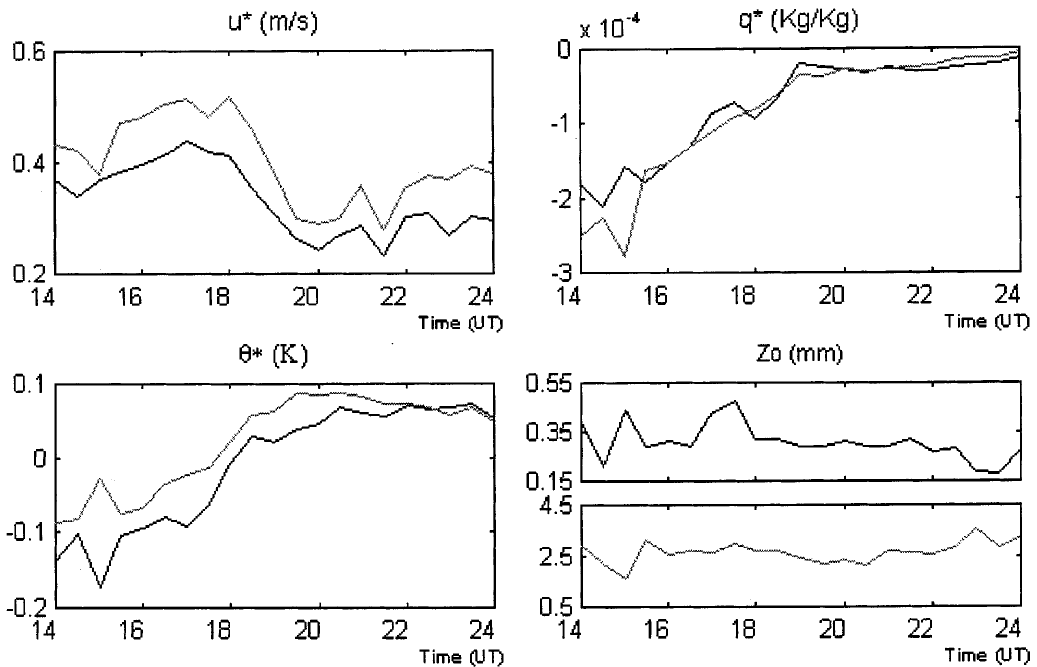
Fig. 14. Scaling parameters of the SBL for both plots CT plot ( black ) and the RT ( grey ) for 24 July (or DOY 205) were calculated every 30 min. Plots show friction velocity ( top left ), potential temperature